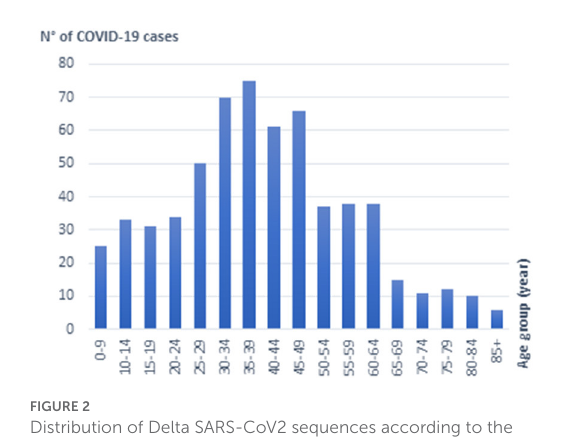
FIGURE2 Distribution of Delta SARS-CoV2 sequences according to the